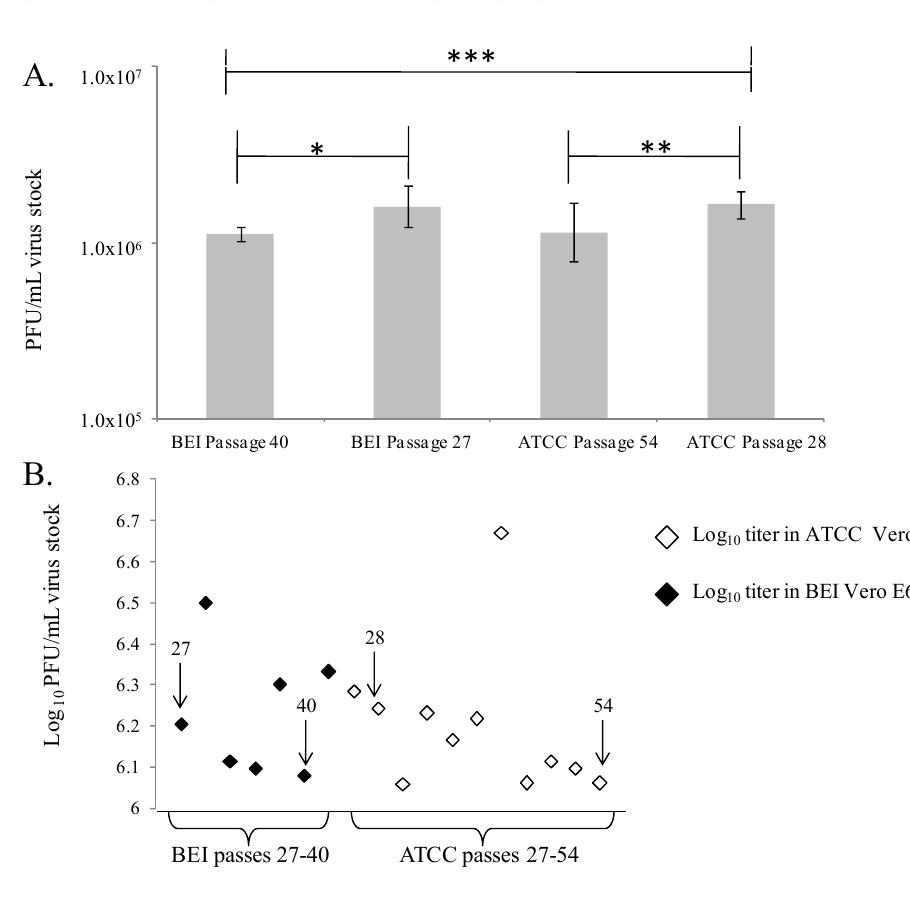
Figure 3. ( A ) EBOV titers in ATCC or BEI Vero E6 cells of various passage ages. This experiment was performed by three independent investigators, four replicates per cell type. The combined data are presented, where each bar represents 12 replicates. * indicates a significant difference in value between BEI passage 40 and passage 27 ( p = 0.0003), ** a difference between ATCC passage 54 and 28 ( p = 0.007), and *** a difference between BEI passage 40 and ATCC passage 28 ( p = 0.000002). For these experiments, p value cutoff was ≤ 0.008). ( B ) Analysis of EBOV titer changes in cells of various passages. The arrows point out data from passages plotted in